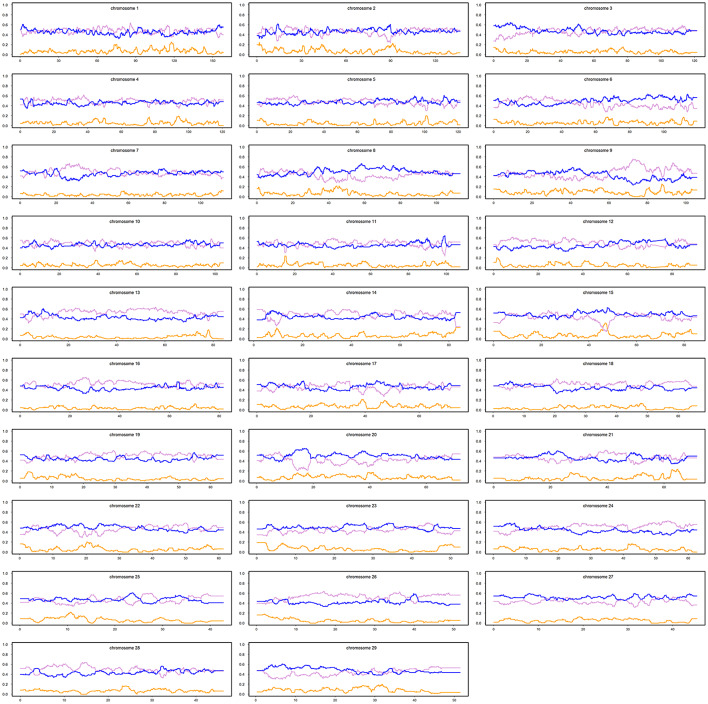
Average local ancestries of the admixed cattle with three or more crossovers per Morgan in the haplotype carrying the lowest number of crossovers. The gray, yellow, and blue lines represent Bos indicus, African Bos Taurus, and European Bos taurus ancestry, respectively.